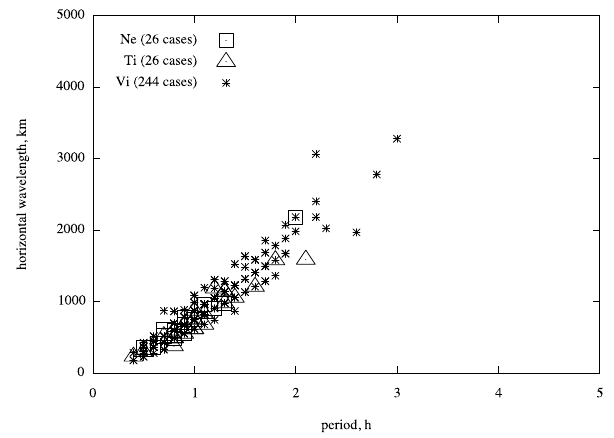
the cases are presented in Fig. 15 as a function of period.